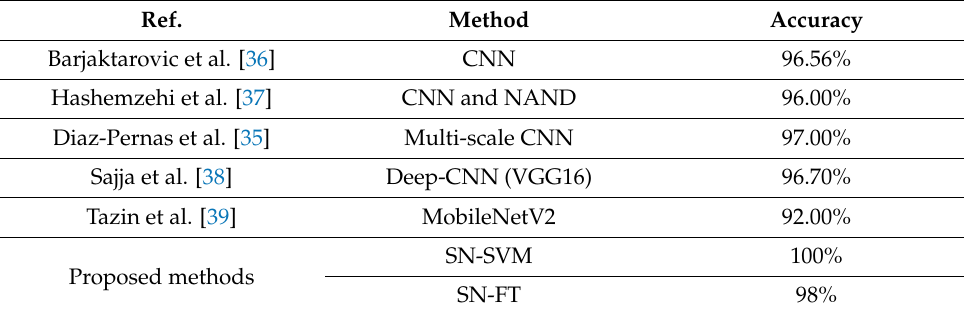
Table 6. Performance results using public dataset.